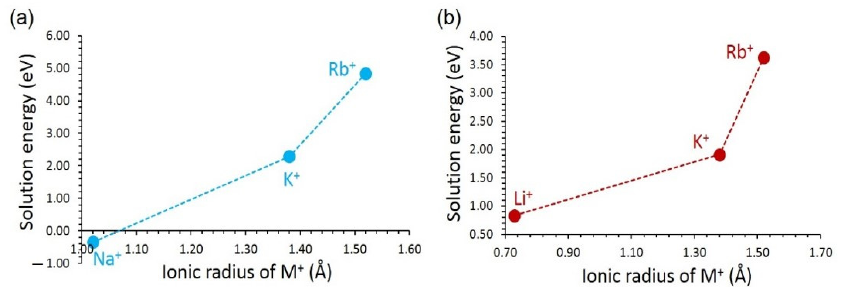
Figure 6. Solution energy of M 2 O with respect to the M + ionic radius in ( a ) LiVSi 2 O 6 and ( b ) NaVSi 2 O 6 .